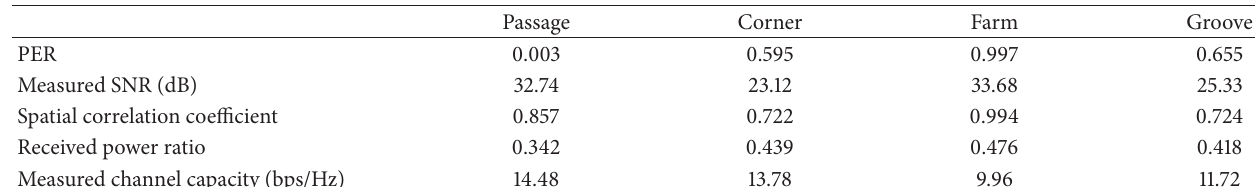
Table 2: Summary of experimental results for basic antenna.